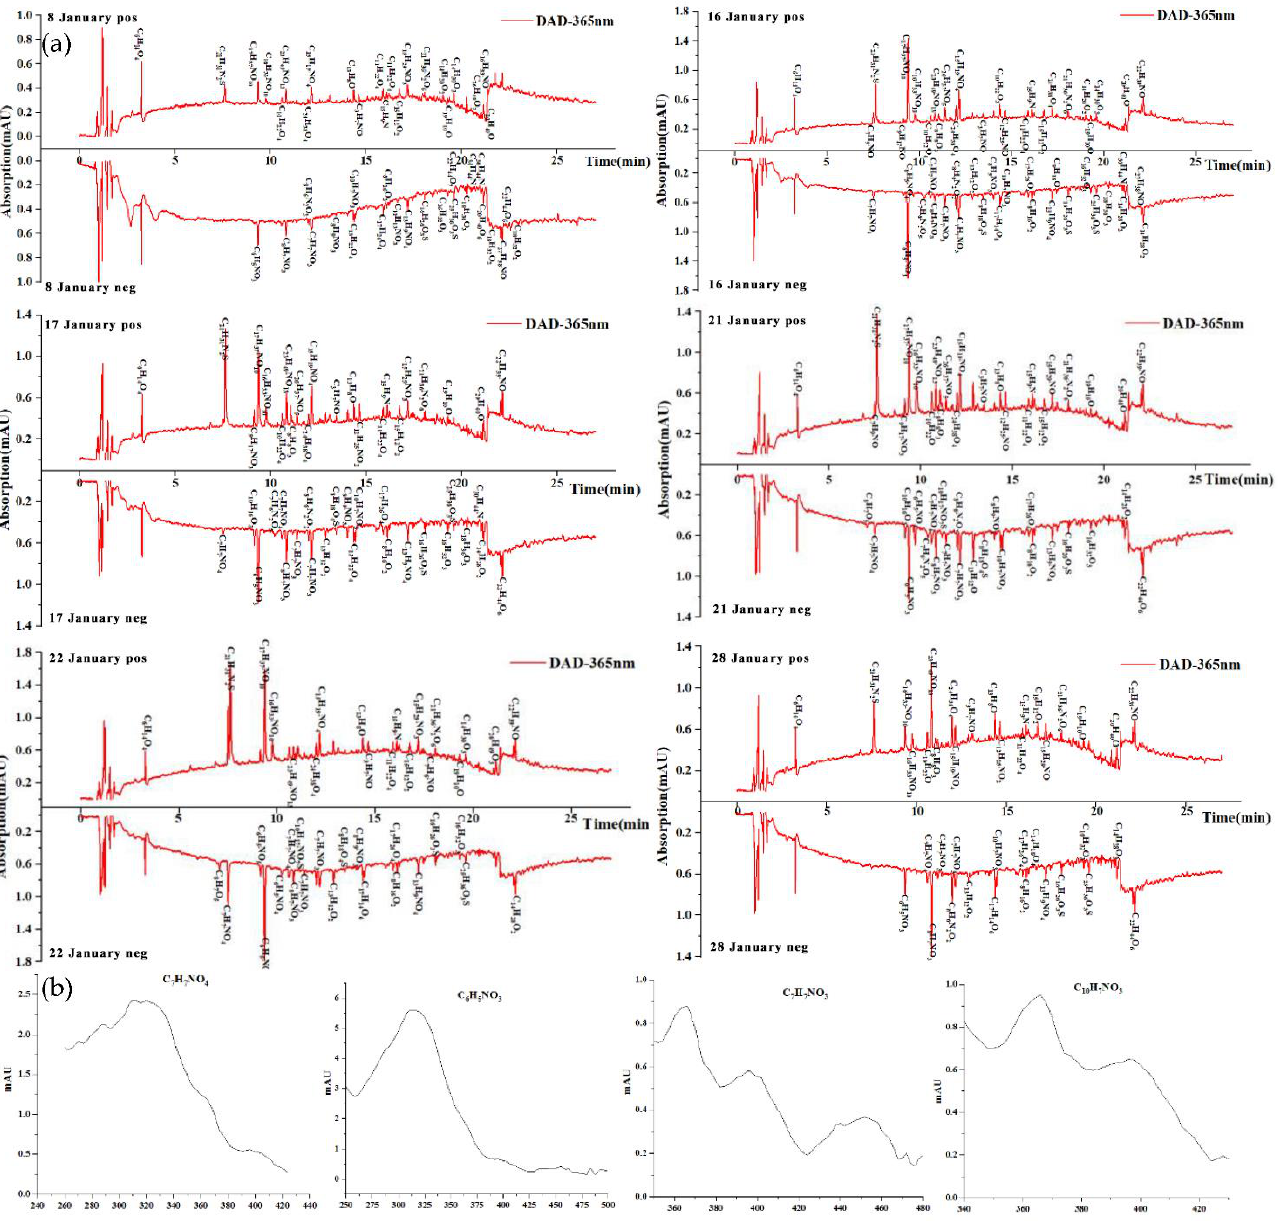
Figure 5. ( a ) HPLC-DAD chromatograms of atmospheric particle samples. The molecular formula on the peak denotes BrC chromophores with well distinguished UV–vis spectra; ( b ) Selected examples of the UV–vis spectra from the above chromophores and their corresponding elemental composition as inferred from high-resolution mass